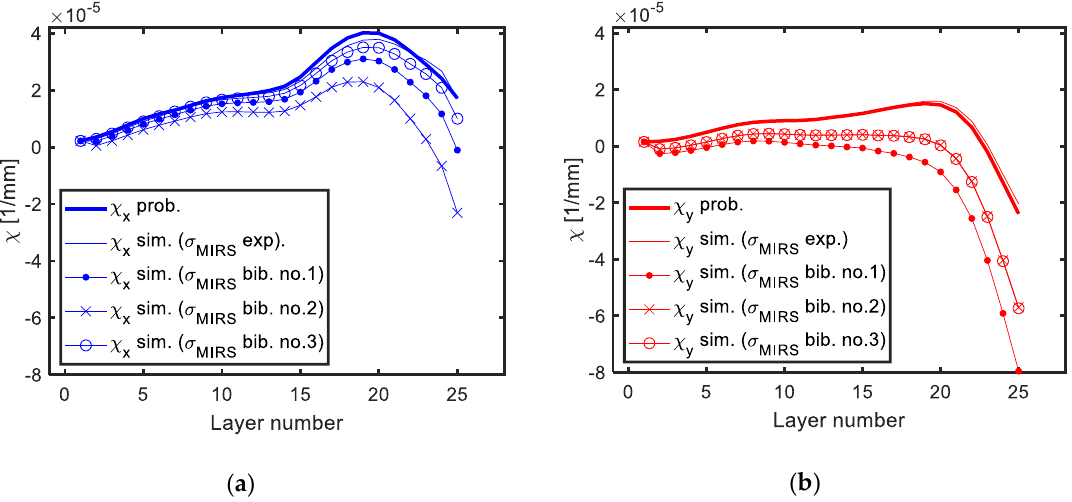
Figure 14. Sensitivity analysis of the LR method to different machining parameters: Actual curvatures measured by probing, simulation results from experimental MIRS, and simulation results from bibliography MIRS [35] in X direction ( a ) and in Y direction ( b ).